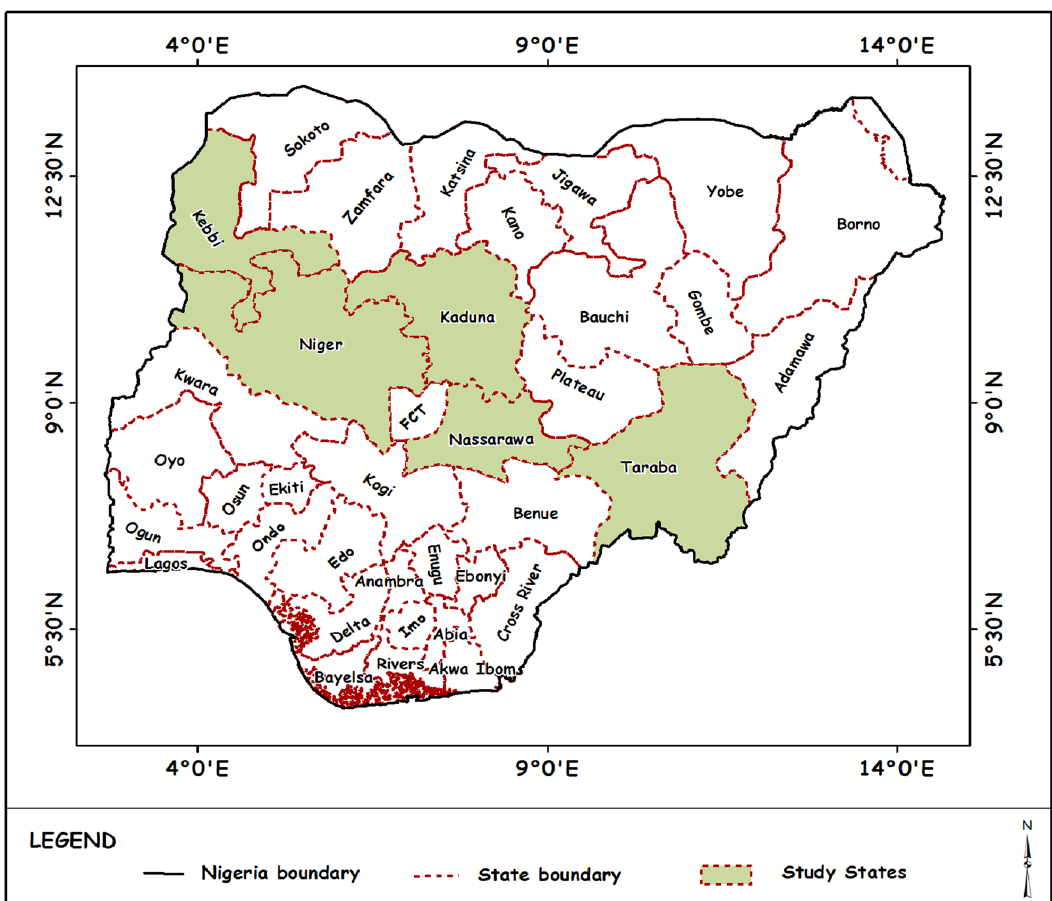
Figure 1: Map of Nigeria showing the study